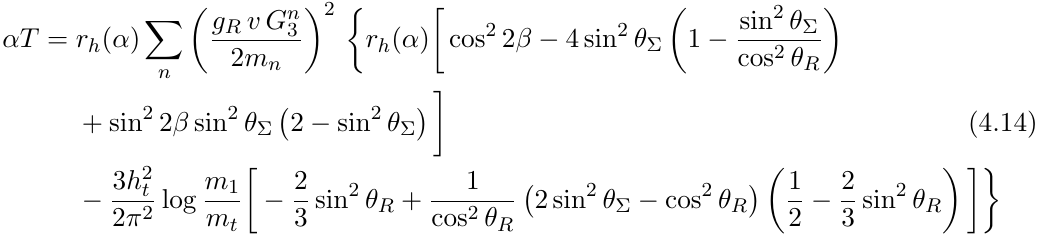
Figure 3 . The region between the solid lines is allowed by (cid:14)g Z (cid:12)gure 2) and by the 95 % C.L. bound on the T parameter, for m 1 = 3 TeV and tan (cid:12) = 1 (black lines), tan (cid:12) = 3 (blue lines) and tan (cid:12) = 5 (red